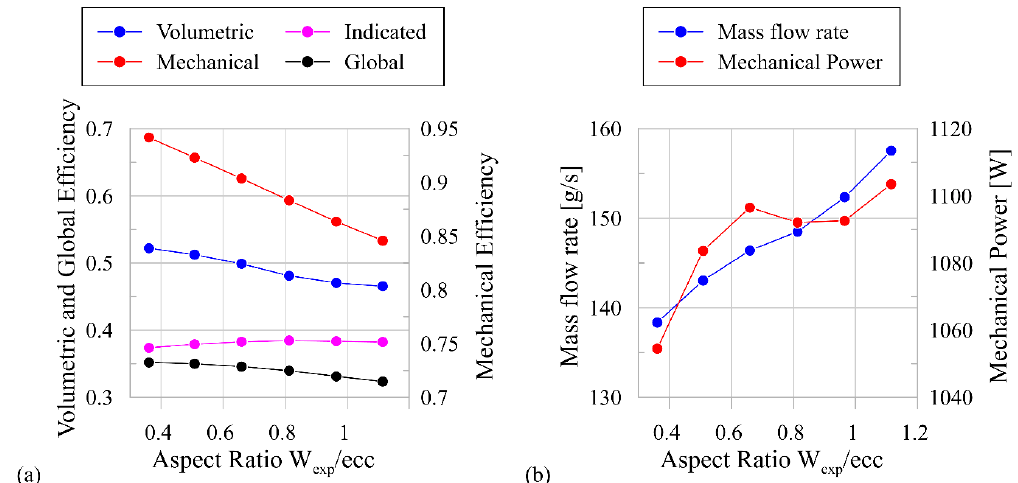
Figure 14. Results of the model-based design increasing revolution speed up to 2000 RPM: ( a ) global, volumetric, indicated and mechanical efficiency; ( b ) mass flow rate and mechanical power. The rotor diameter was fixed to 65 mm.